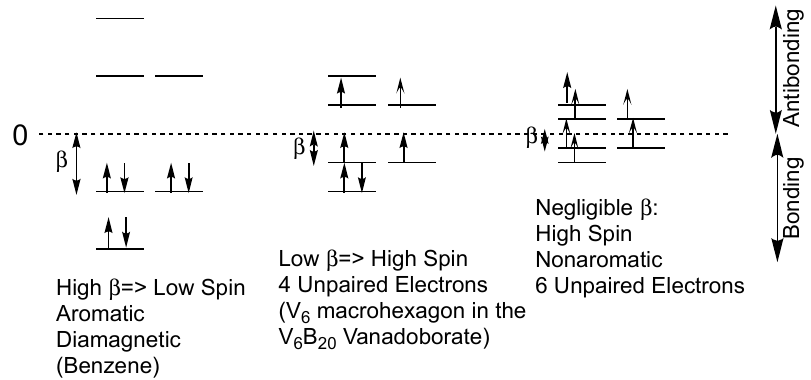
Figure 2. Comparison of the energy levels and spin states in benzene with those in the V 6 macrohexagon in the V 6 B 20 vanadoborates such as [V 6 B 20 O 50 H 8 ] 8 − .